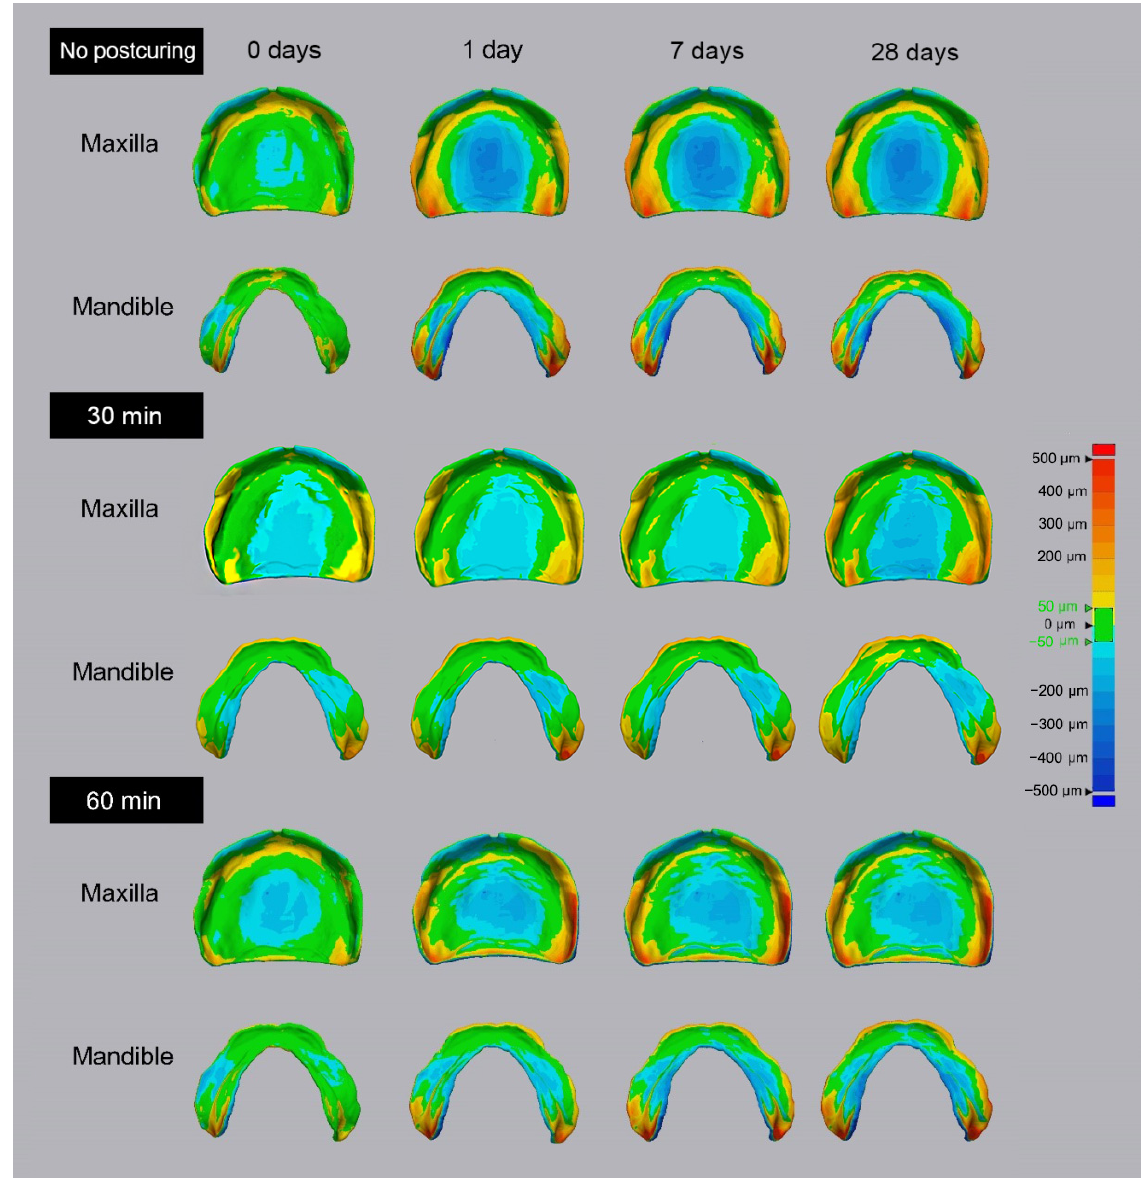
Figure 7. The 3D color maps at 0 days, 1 day, 7 days and 28 days after printing of the no postcuring, and 30 min and 60 min postcuring groups. Comparing the no postcuring group with the 30 min and 60 min postcuring groups, postcuring time increases, and the dimensional change is